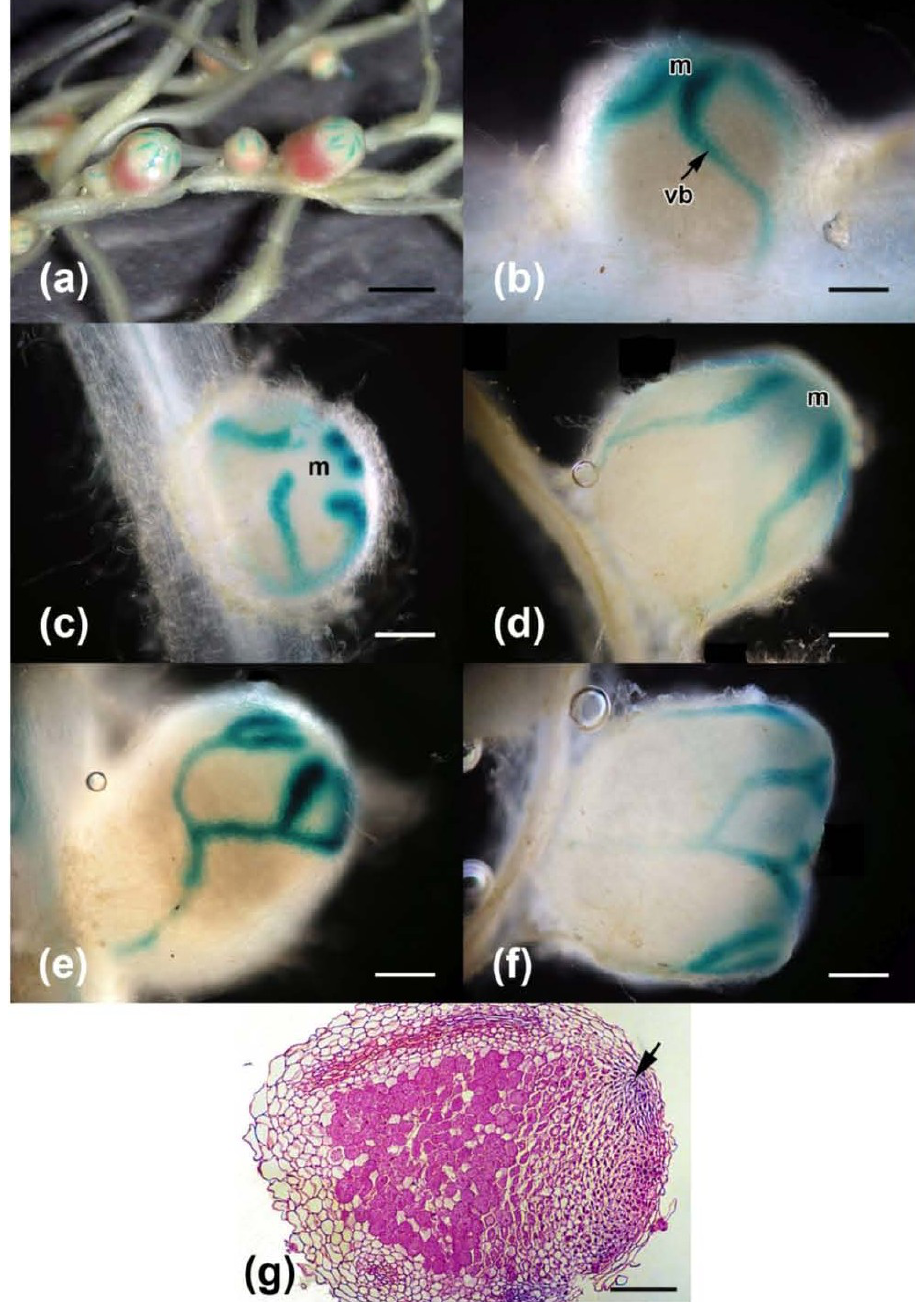
Figure 5. Effect of coinoculation; ( a ) A cluster of nodules of different ages showing GUS staining in the young vascular bundles; 32 dpi. The red color is due to the presence of leghemoglobin. Bar, 2 mm; ( b ) A young nodule (14 dpi) exhibits localization of GUS activity in the nodule meristem (m) and young vascular bundles (vb); ( c ) Loss of GUS staining in the nodule meristem (m); 14 dpi; ( d ) Retention of some GUS staining in the meristem (m); 32 dpi; ( e ) Branching of the vascular bundles in a more mature nodule; 32 dpi; ( f ) A nodule with extensive vascular development; 32 dpi; ( g ) Near-median plastic section of a 26 dpi nodule originally stained for GUS, which is localized towards the apical end near the vascular bundle (arrow). The section was stained with safranin O. Bars for ( b ) through ( g ), 200